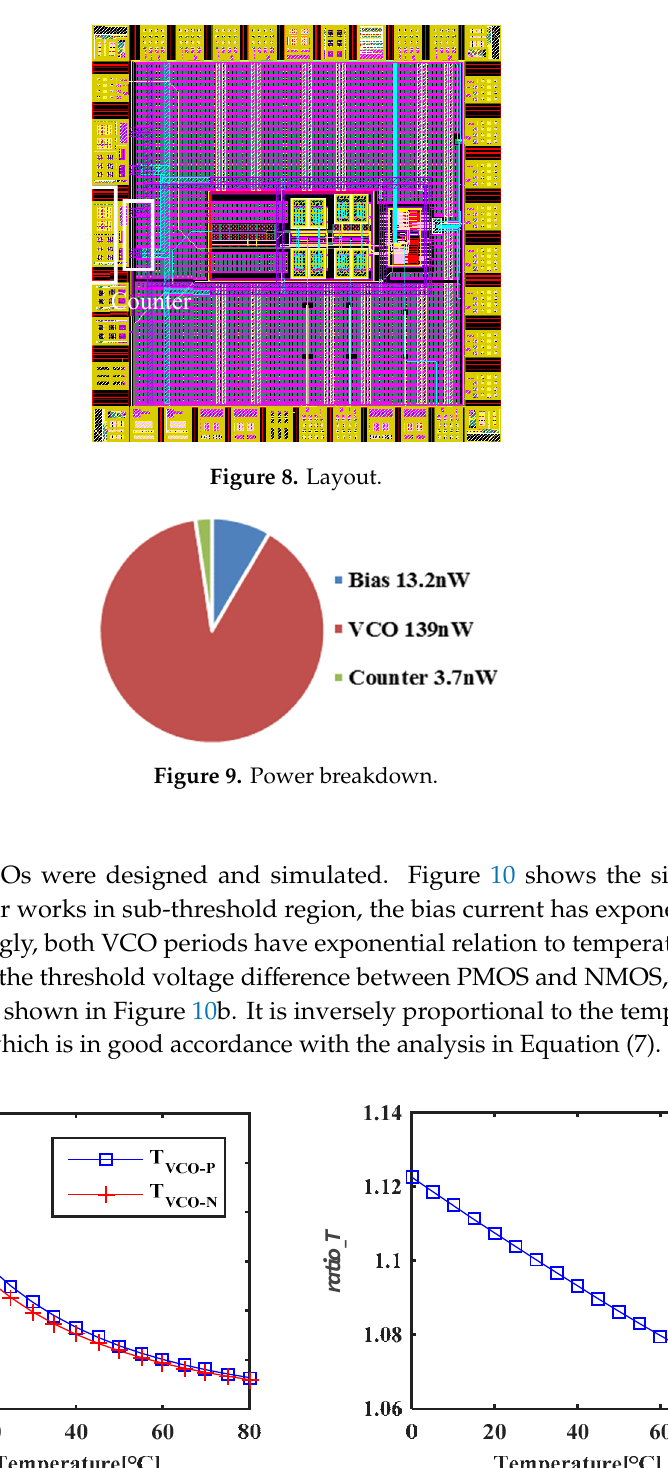
( b ) Figure 11. Simulated temperature error ( a ) after 1st order polyfit, ( b ) after 2nd order polyfit. The proposed temperature sensor exhibits a systematic error profile dominated by the nonlinearity of ratio_T across the temperature range which is in good accordance with the analysis in Equation (7). After 1st order polyfit and the nonlinearity removal (Figure 12a), a maximum temperature error of +0.37 °C/ − 0.32 °C was observed across a 0 °C to 80 °C temperature range. After 2nd order polyfit and the nonlinearity removal (Figure 12b), a maximum temperature error of +0.17 °C/ − 0.19 °C was observed.